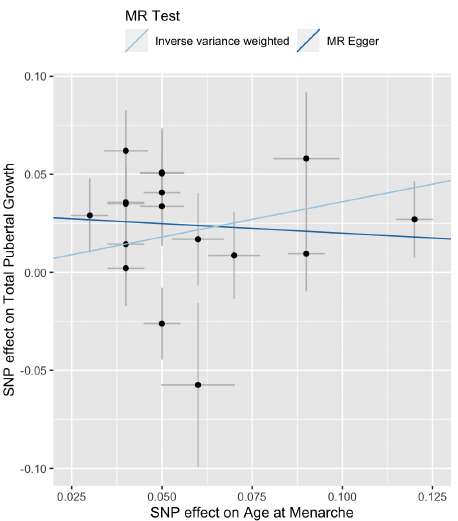
Figure 5. Scatter plot of { Γ i } versus { γ i } for total pubertal growth. The slopes of the two lines are the MR estimates of the causal effect. The right-most point corresponds to SNP rs7759938 in the LIN28B